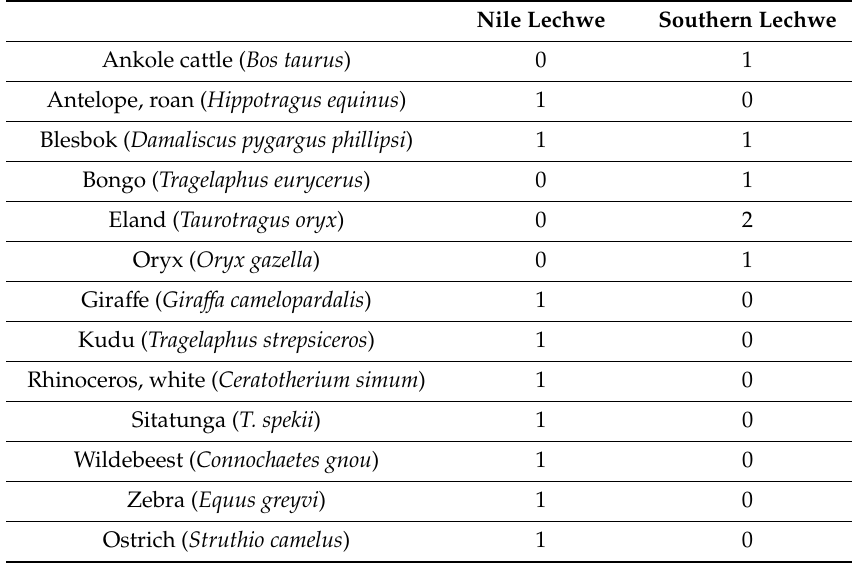
Table A2. Aggressive interactions documented from the survey between male lechwe and other animal species within mixed taxa